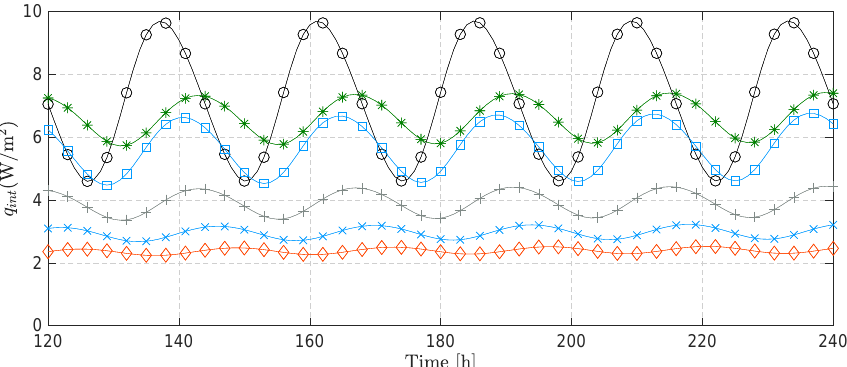
Figure 18. Heat flux distribution over time at the interior surface of the ICB-substrate system: ( ∗ ) without canopy, e = 0.10 m; ( ◦ ) e = 0.00 m; ( (cid:3) ) e = 0.05 m; (+) e = 0.10 m; ( × ) e = 0.15 m; ( (cid:5) ) e = 0.20 m.